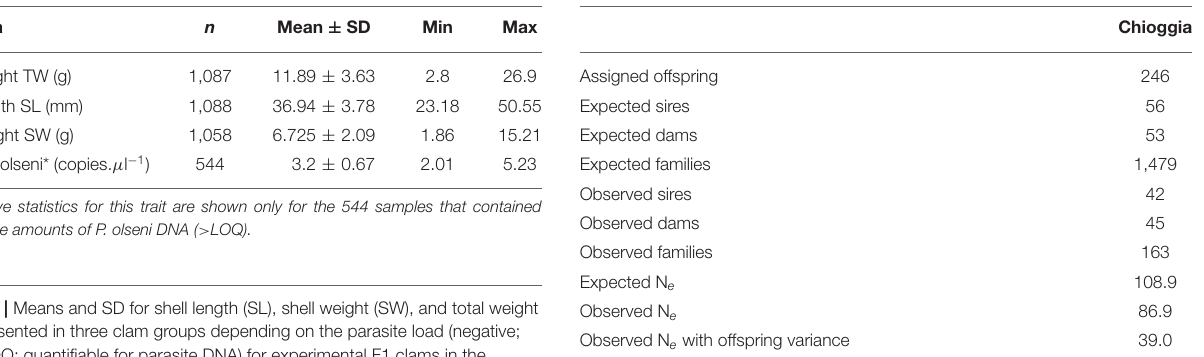
TABLE 5 | Genetic variability: parent representation and effective size ( N e